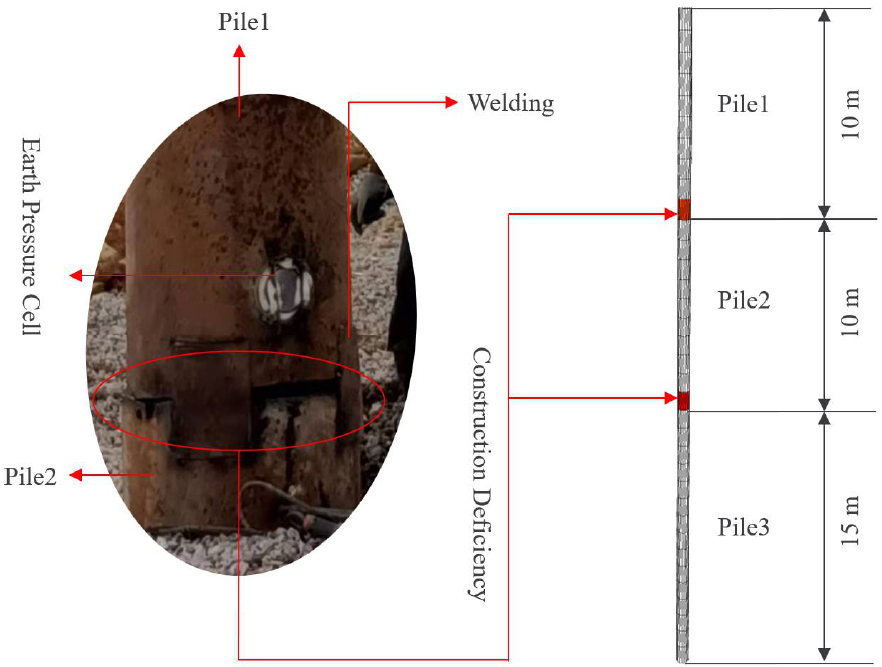
Figure 4. The schematic diagram of the welding joints of the steel pipe pile.